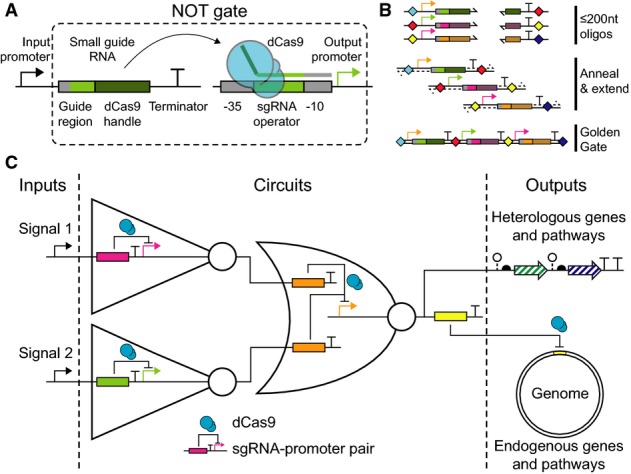
Schematics of dCas9 logic circuit design and constructionCRISPR/Cas-based NOT gates comprise a catalytically dead dCas9 protein, an input promoter that
transcribes a small guide RNA (sgRNA), and a synthetic output promoter with an sgRNA operator
between the –35 and −10 sigma factor binding sites. When the dCas9 handle of the sgRNA
(dark green) complexes with dCas9 (blue), the sgRNA binds the operator (light green) and a sigma
factor binding site (gray), causing steric repression of transcription initiation at the output
promoter.CRISPR/Cas genetic circuits are easily constructed from pairs of ssDNA oligonucleotides ≤
200 nt long that encode the necessary genetic parts (promoter, sgRNA, terminator, assembly scars,
and restriction enzyme recognition sites). These oligos are annealed to each other at the dCas9
handle and extended. The resulting dsDNA modules are assembled in a one-pot Golden Gate assembly
reaction. (Colored diamonds are assembly scars.)Genetic circuits that respond to chemical input signals can be constructed from simple NOT and
NOR gate motifs. In these circuits, dCas9 (blue) mediates repression of synthetic promoters by
programmable sgRNAs (visualized as solid colored rectangles from here on). Both heterologous and
endogenous genes can be regulated at circuit outputs by expressing sgRNAs tailored to target
transcription initiation or elongation.